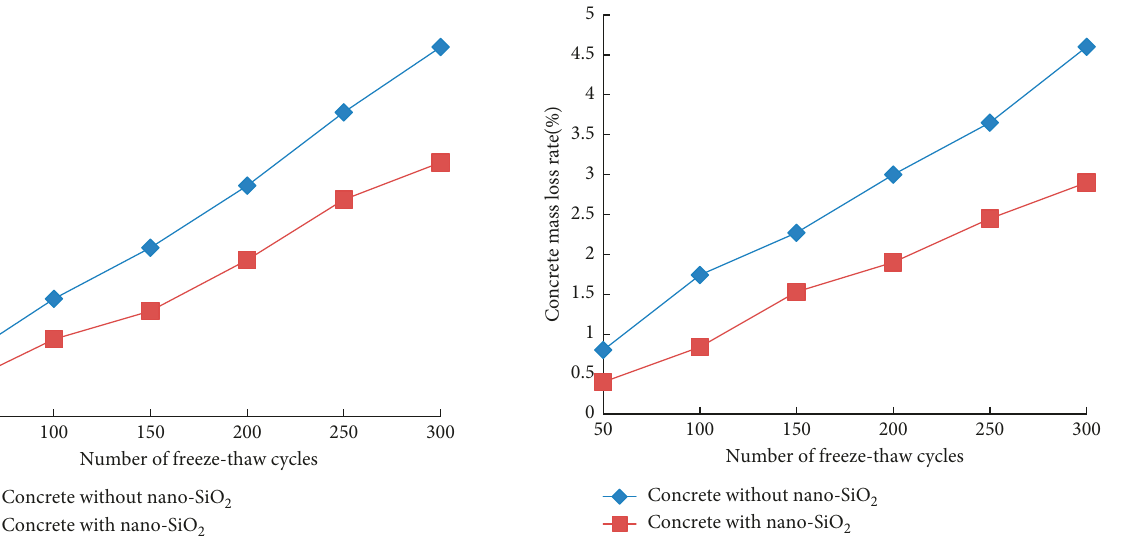
Figure 6: Variation of mass loss rate with freeze-thaw cycles in chloride salt environment.